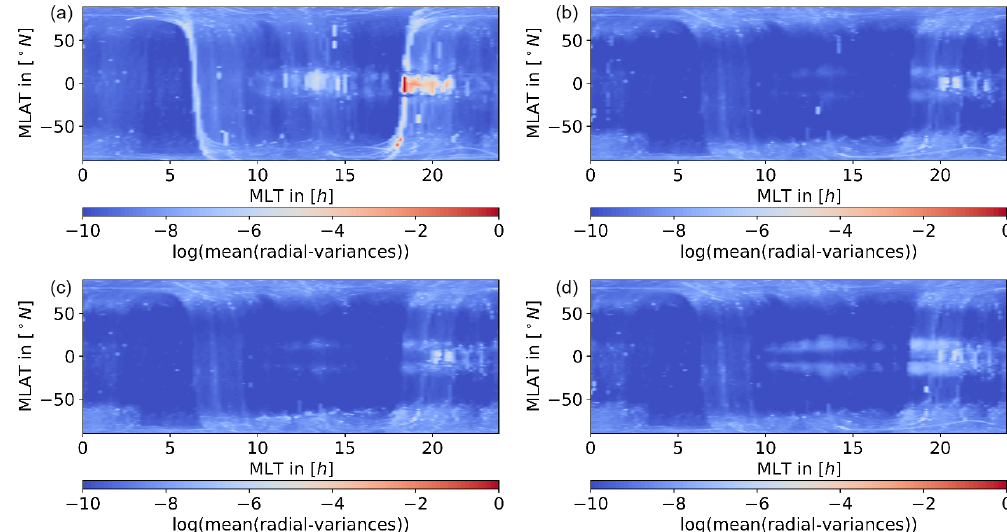
Figure 15. Radial variances in magnetic coordinates. (a, b) AIUB standard screening (a) and AIUB-ROTI (b) ; (c, d) Graz-ROTI (c) and second derivative limited to the equatorial region (eq.) + AIUB-ROTI (d) .